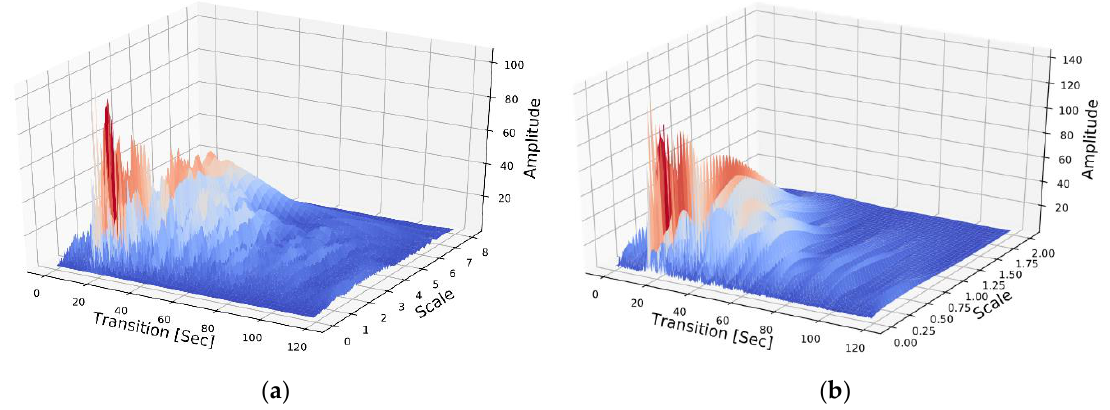
Figure 3. Amplitude spectra of the time series by ( a ) Shannon wavelets and ( b ) Gabor wavelets.